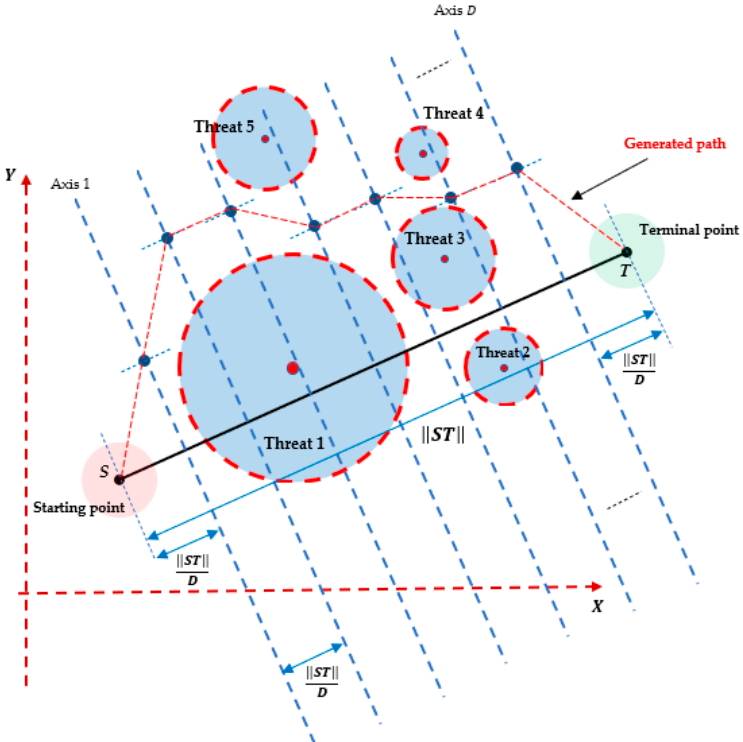
Figure 1. The schematic diagram for modeling the combat field. The X and Y axes represent the length and width of the horizontal battlefield, respectively. S and T indicate the starting and terminal points, respectively. All blue circles represent the threats on the battlefield. The black line connecting S and T directly represents the segment ST . The blue points indicate all generated nodes, which must be linked together to construct the optimal path indicated by the red dashed line.